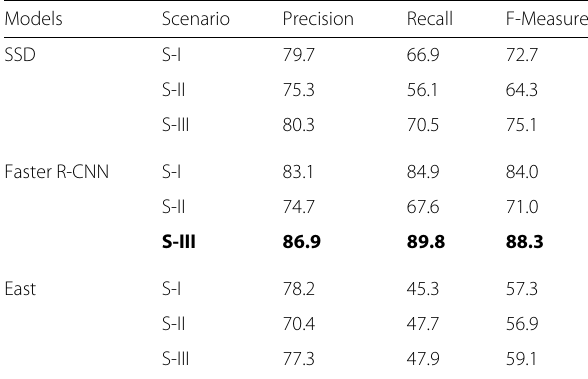
Table 3 Text detection results on three experimental scenarios using different